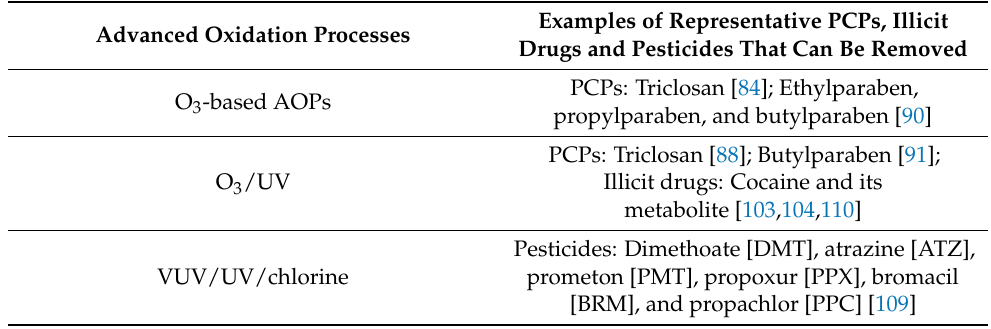
Table 4. Examples of representative PCPs, illicit drugs, and pesticides that can be removed by